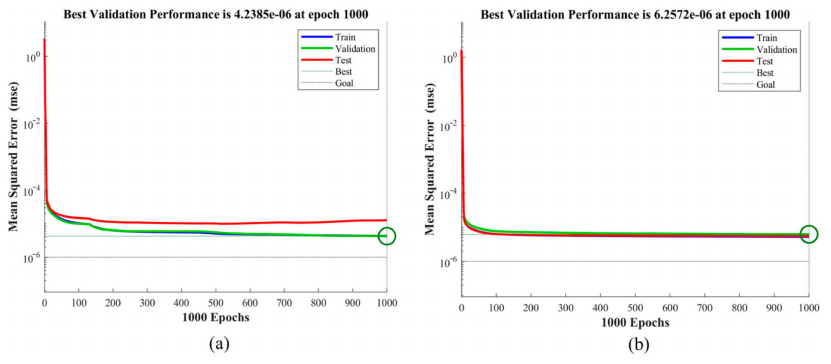
Figure 9. Network performance change diagram of model training process: ( a ) MSE of the x- and y-axis; ( b ) MSE of the